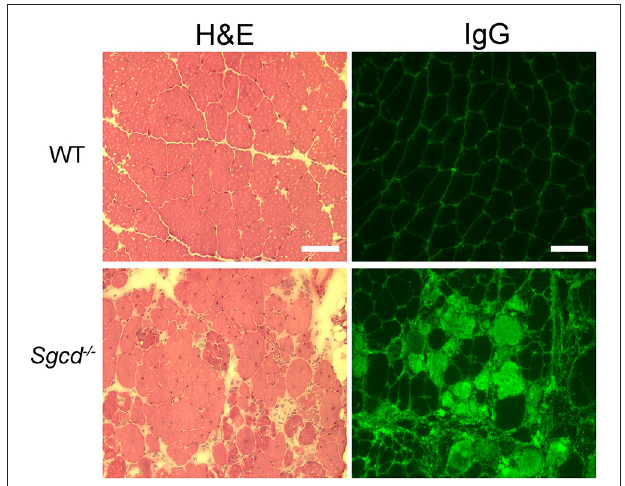
FIGURE 4 | Representative sections of quadriceps muscles from WT and Sgcd − / − mice stained with hematoxylin and eosin (left) or for IgG (right) . IgG serves as a marker of muscle membrane damage. Severely dystrophic skeletal muscles are observed in 20 week-old Sgcd − / − mice as observed by myofibers with intracellular serum proteins, centrally located nuclei indicating previous degeneration and regeneration of the fiber, and a wide variation in fiber size, as well as interstitial cellular infiltrate and fibrosis. Bar = 100 µ m.